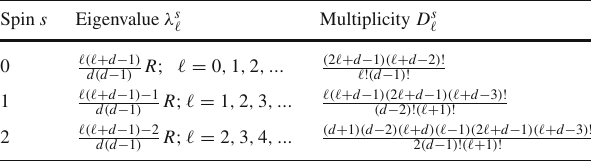
Table 4 The eigenvalues λ s (cid:15) and their multiplicities D s (cid:15) for spin 0 (scalar), spin 1 (transverse vector), and spin 2 (transverse traceless ten- sor) fields of the operator −∇ 2 on the sphere (taken from [81,82]) Spin s Eigenvalue λ s (cid:15) Multiplicity D s